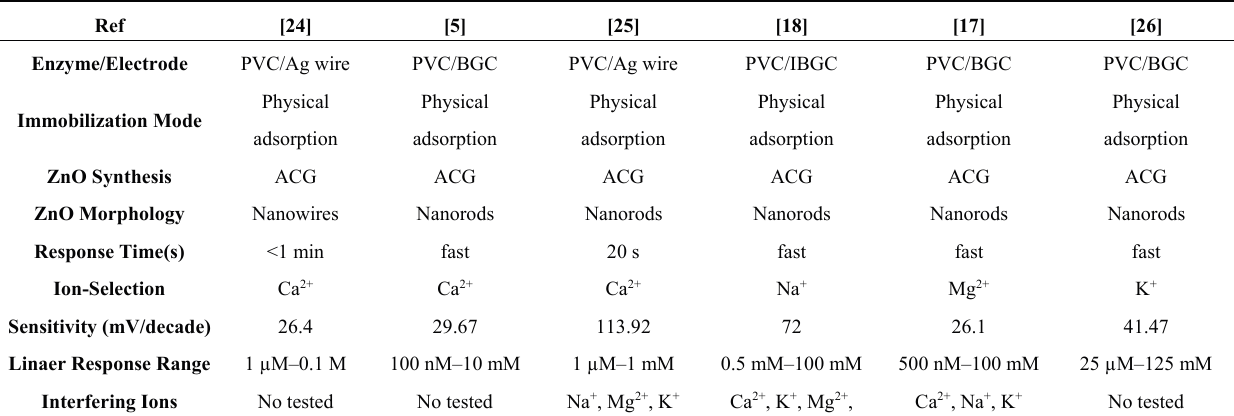
Table 1. Summary of ZnO nanostructure-based intracellular metal ion-selective biosensors (PVC: Poly Vinyl Chloride; BGC: Borosilicate Glass